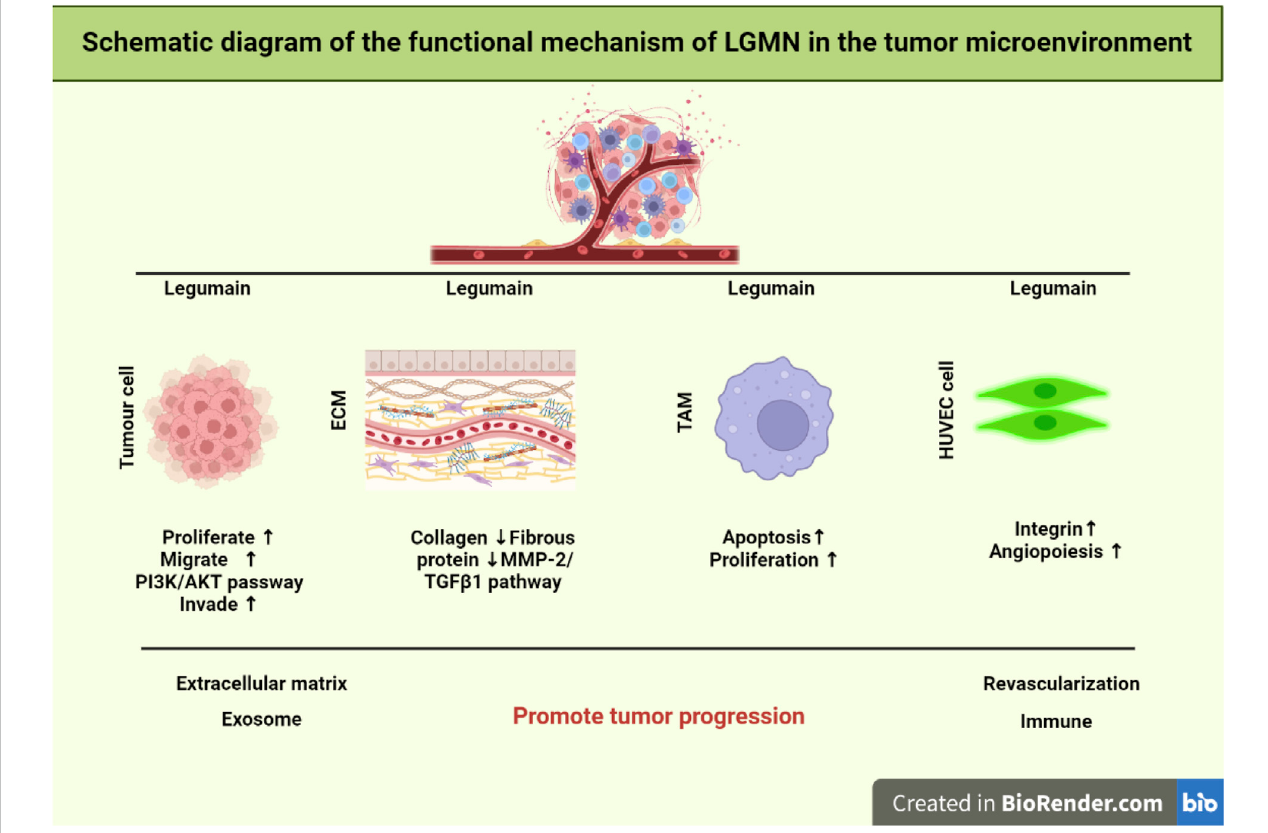
FIGURE 1 Schematic representation of LGMN functional mechanism in the tumor microenvironment. It was found that the TGF-3/FAK pathway targets lipid metabolism to overcome the treatment resistance related to EMT. LGMN activation is exploited to induce TAM repolarization. Whereas cellular proliferation, invasion, and metastasis are all regulated by the PI3K/AKT pathway. Finally, lowering TAM levels in the tumor stroma can drastically modify the tumor microenvironment, hence limiting tumor development and